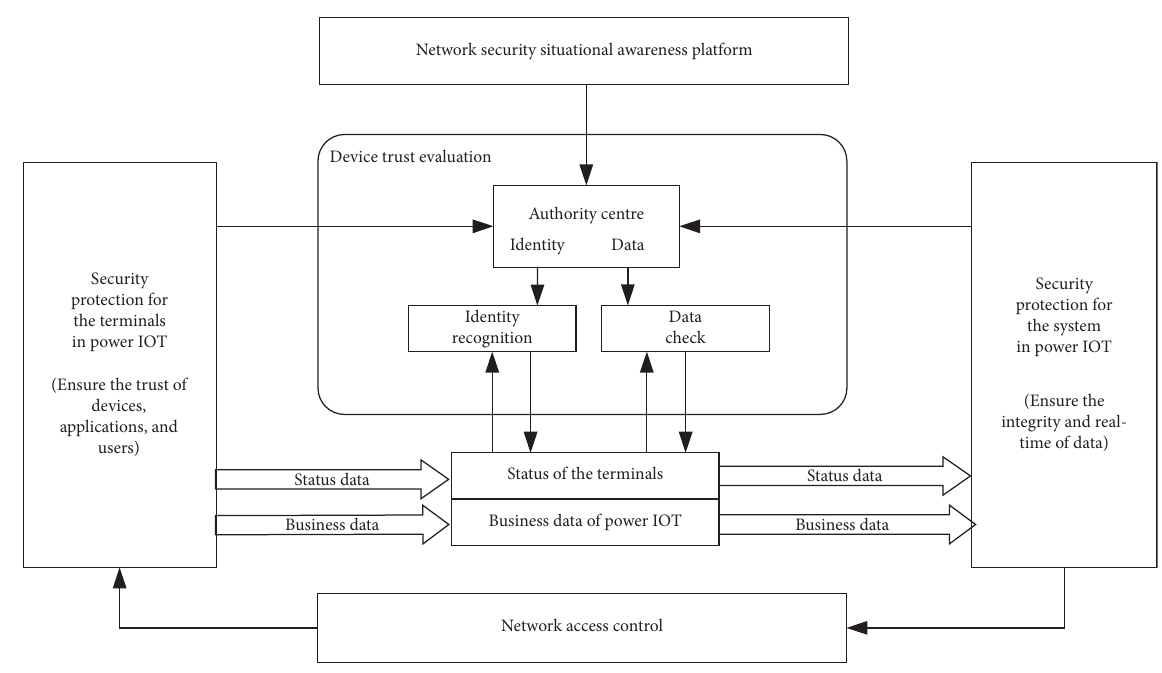
Figure 2: Te ZTM in the power